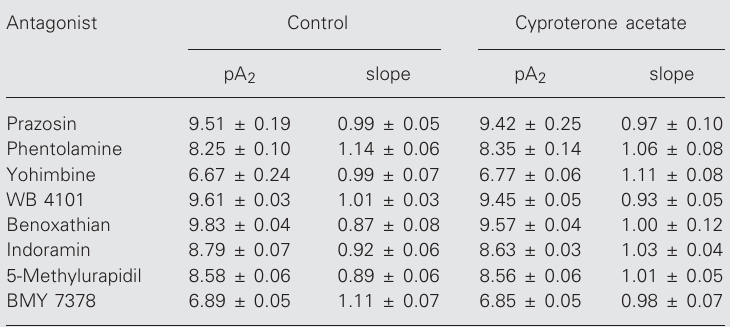
Table 2. Effect of cyproterone acetate treatment on the pA 2 and slope values of α - adrenoceptor antagonists against noradrenaline-induced contractions of vas deferens.